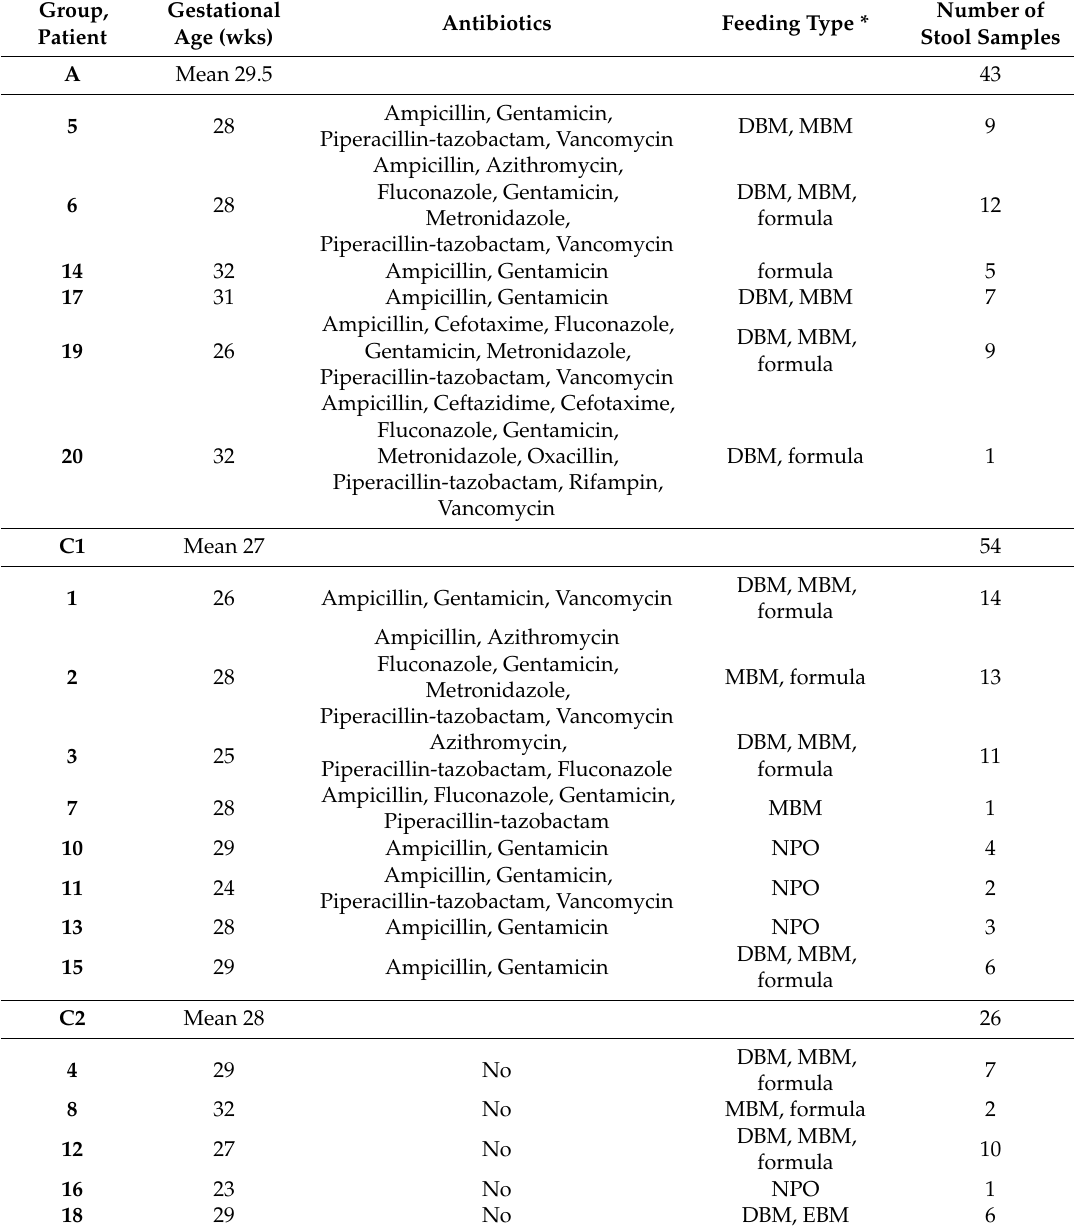
Table 1. Patient